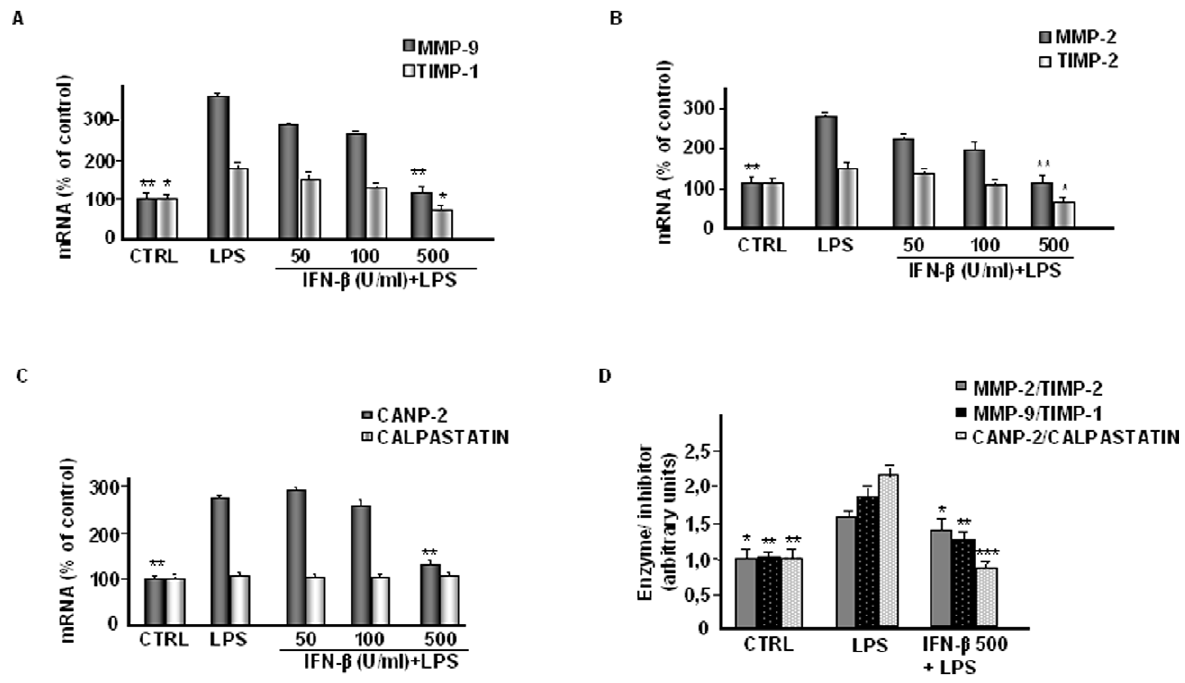
Figure 5. Effect of IFN- b on mRNA expression of the systems enzyme/inhibitor in astrocytes. Primary astrocytes (1 6 10 5 cells/ml), incubated in serum-free DMEM, were treated with IFN- b at the indicated concentrations (U/ml) in the presence of LPS (10 m g/ml). The control (CTRL) was represented by non-activated and untreated cells. After 24 h of incubation total cellular RNA was isolated as described in the Methods section and analyzed by RT-PCR, using the primer pairs specific for MMP-2, MMP-9, TIMP-2, TIMP-1, CANP-2, calpastatin and GAPDH. Histograms in A-C, represent the quantitation of target genes, after normalization with GAPDH, from three separate experiments with different cell populations. CTRL mRNA levels were set at 100% and the LPS or IFN- b treatments were represented as percent of control (mean 6 SD). Values statistically different from positive control (LPS-activated cells) are represented by * (One-way Anova followed by Student – Newman – Keuls post hoc test; *P , 0.05; **P , 0.005). D, Effect of IFN- b on MMP-9/TIMP-1, MMP-2/TIMP-2 and CANP-2/calpastatin mRNA ratios. The MMP-9/TIMP-1, MMP-2/TIMP-2 and CANP- 2/calpastatin mRNA ratios were calculated from the levels of individual genes, expressed as percent of negative control. The histogram represents the mean values 6 SD of three separate experiments performed with different cell populations. Statistically significant values different from positive control (LPS-activated astrocytes) are indicated with * (One-way Anova followed by Student – Newman – Keuls post hoc test; *P , 0.05; **P , 0.005; ***P ,